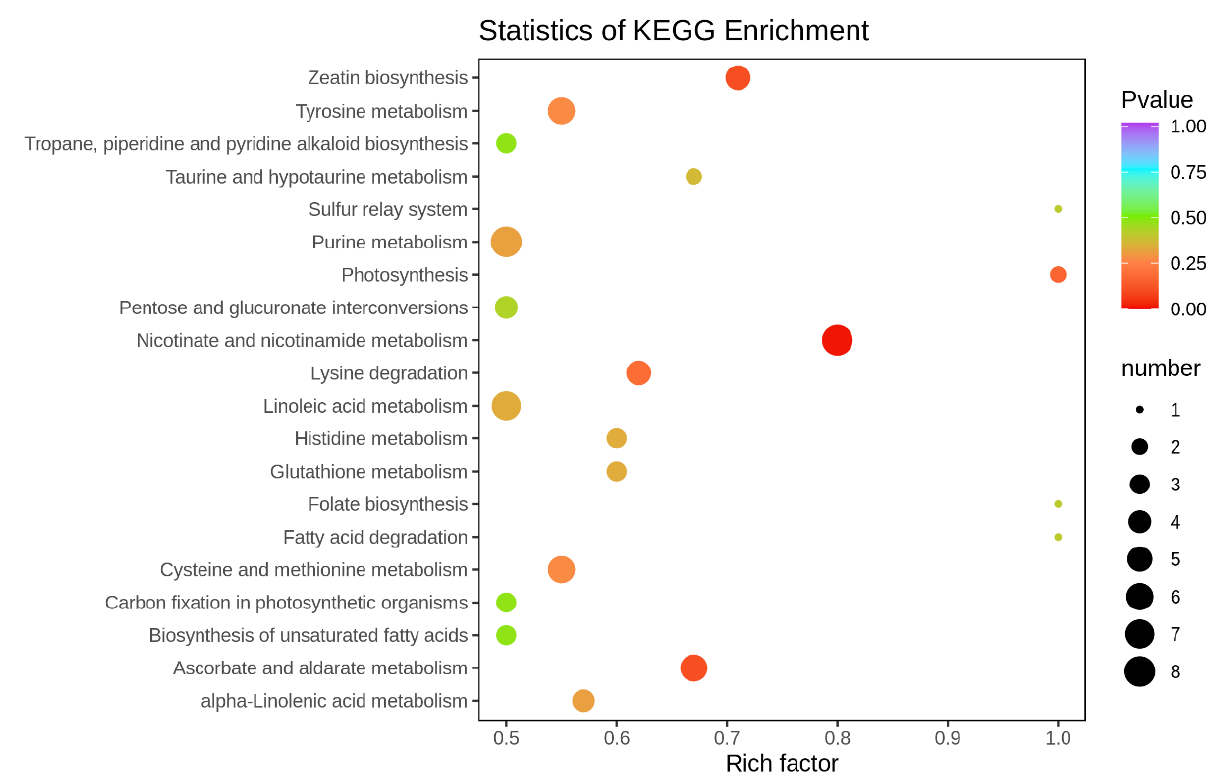
Figure 4. Results of KEGG pathway enrichment analysis. The x -axis represents the enrichment factor, and the y -axis represents the various pathways. The dot color represents the p value, and the dot size represents the number of differentially accumulated metabolites.